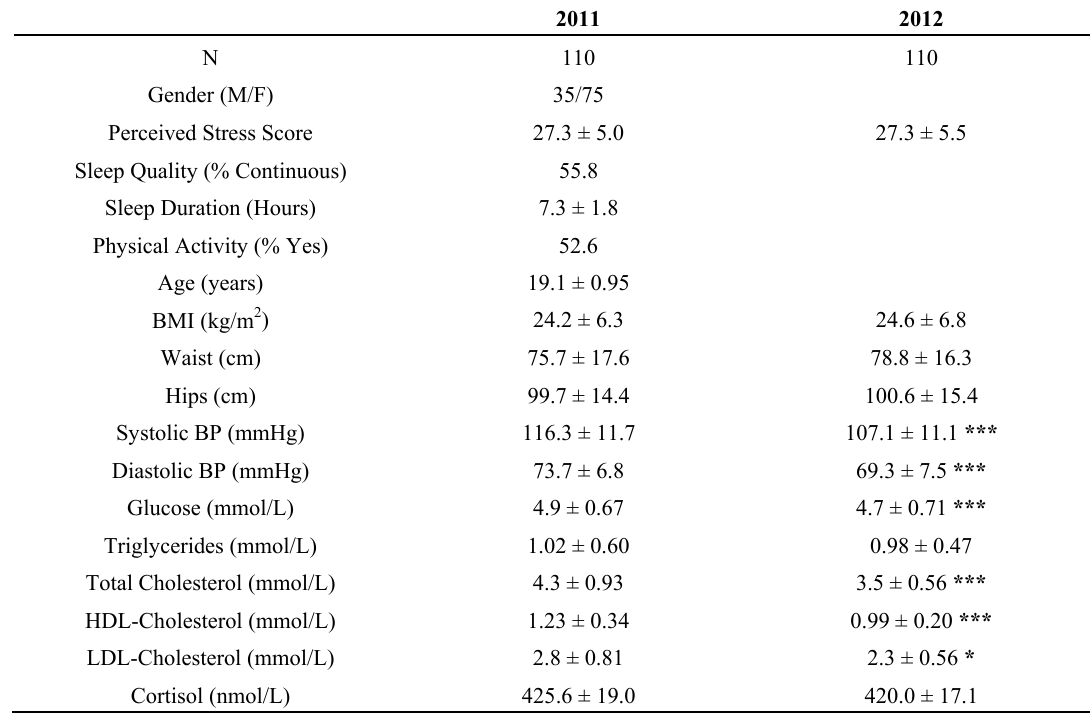
Table 1. General Demographic and Clinical Characteristics of the